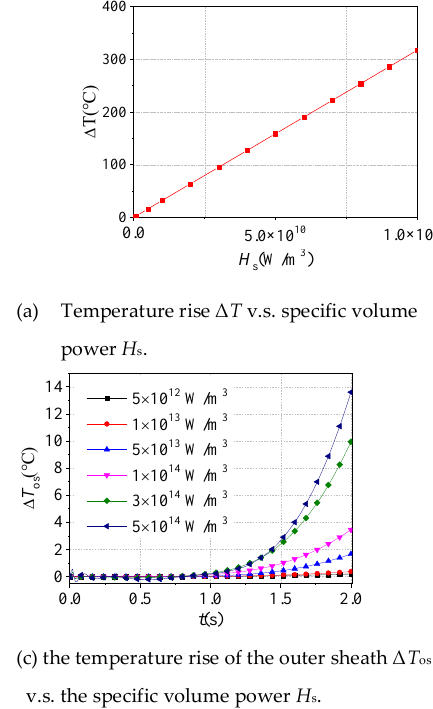
Figure 4. The temperature rise of the cable under arc charge.